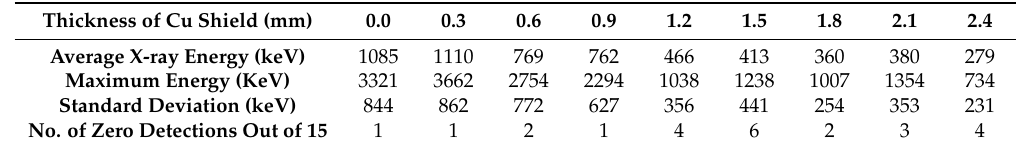
Table 1. Average, minimum, maximum, standard deviation and zero detections of X-ray energy vs. Cu Shield thickness: The average is taken from each series consisting of 15 sparks with the given copper shield thickness surrounding the NaI(Tl) X-ray detector.